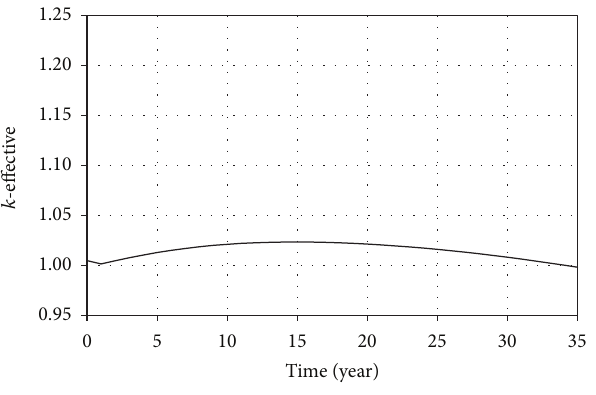
Figure 6: 𝑘 of EM 2 baseline core. eff